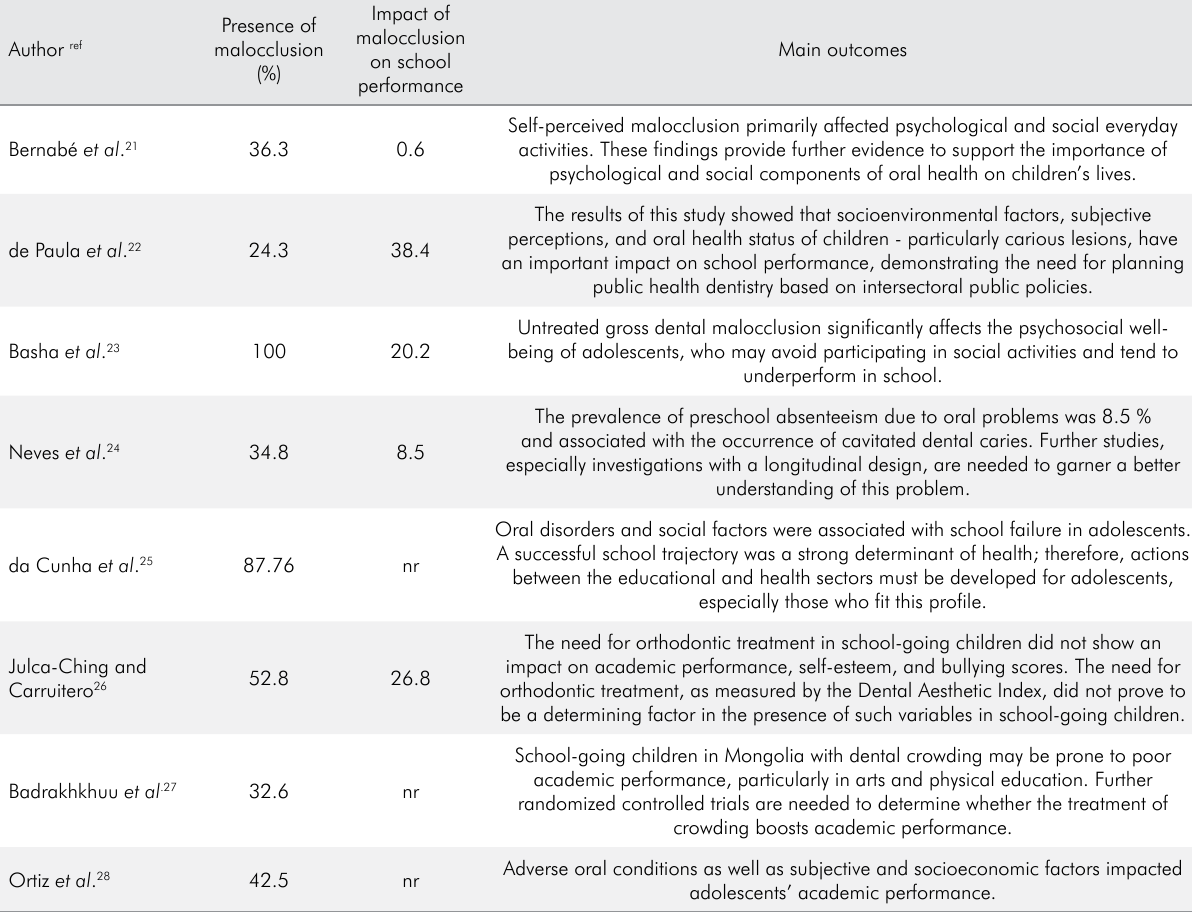
Table 3. Main outcomes of the eligible